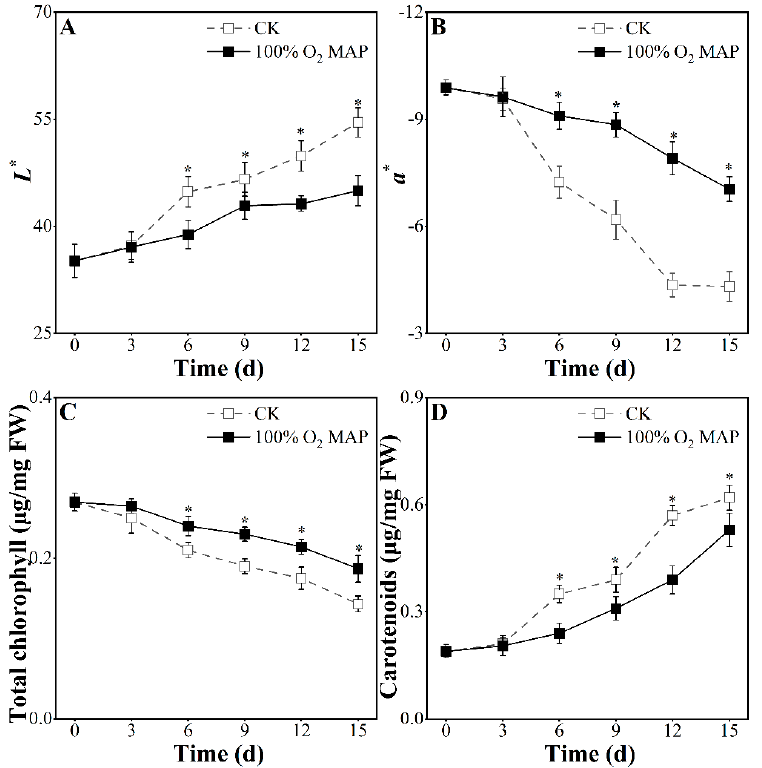
Figure 3. E ff ect of 100% O 2 MAP on L * ( A ), a * ( B ), chlorophyll ( C ), and carotenoids ( D ) of fresh-cut broccoli. * in the figure indicates significant differences among treatments at the same storage time ( p < 0.05).